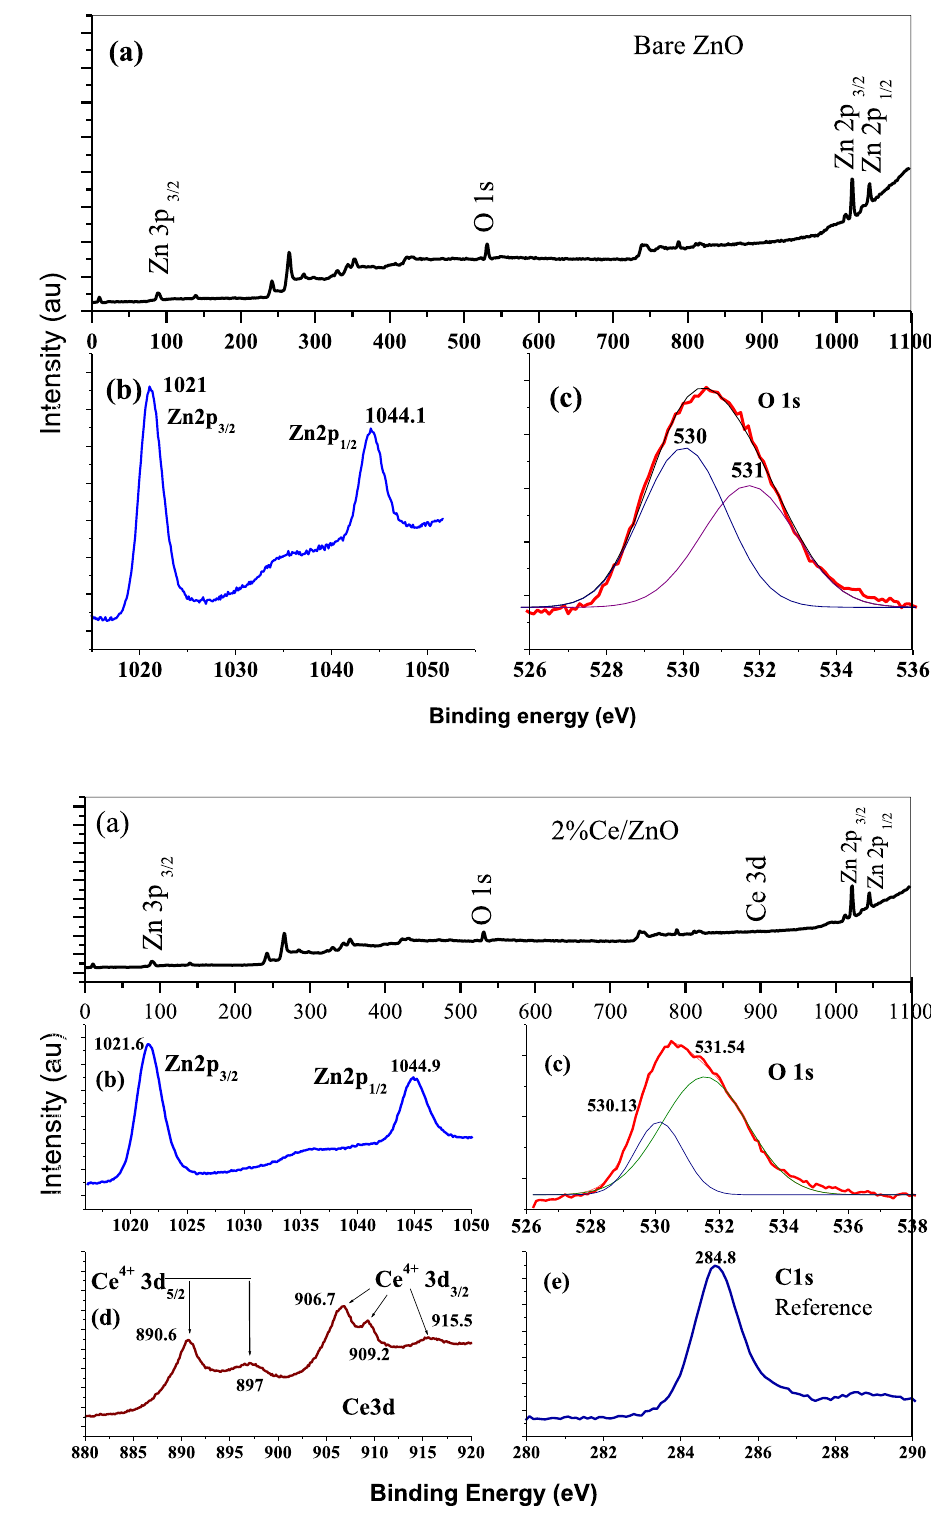
Fig. 8 a Full scan XPS of bare ZnO, High resolution XPS of b Zn2p region, c O1s region